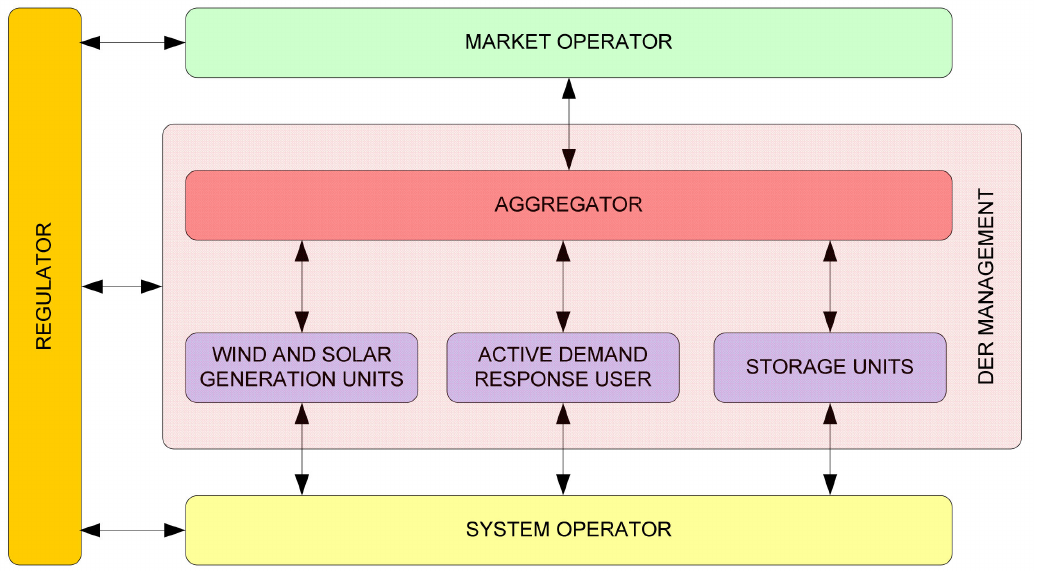
Figure 4. The adaptation of the wholesale electricity